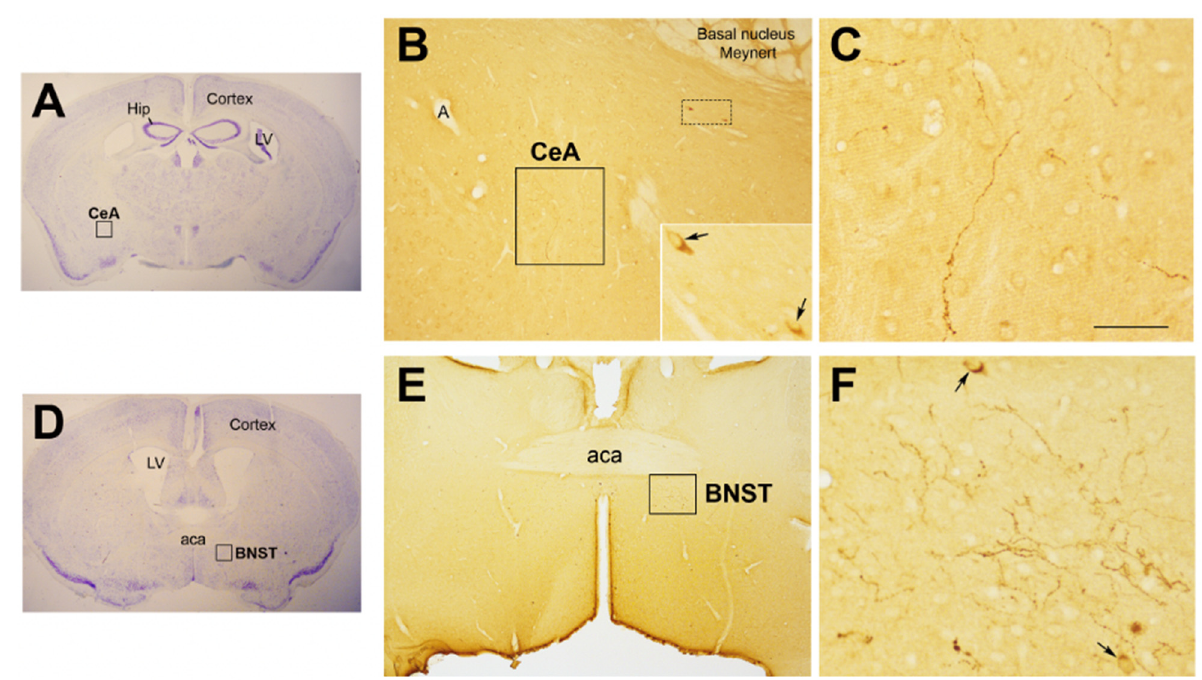
Figure 2. Oxytocinergic projections in the central nuclei of the amygdala (CeA) and in the bed nucleus of the stria terminalis (BNST). ( A ) Light microscopy (LM): Nissl-stained brain coronal section of bregma − 0.94 mm; Hip: hippocampus; LV: lateral ventricle; CeA: central nuclei of the amygdala. ( B ) LM: peroxidase immunohistochemistry of oxytocin (Oxt), showing oxytocinergic fibers (framed area) and two parvocellular Oxt neurons (dotted framed area) in the CeA. Inset: enlargement of the dotted framed area, where Oxt-positive neurons are indicated by arrows. ( C ) Enlargement of the area framed in ( B ), rich in Oxt-positive fibers. ( D ) LM: Nissl-stained brain coronal section of the bregma 0.02 mm; BNST: bed nucleus of the stria terminalis; aca, anterior commissure. ( E ) LM: peroxidase immunohistochemistry of oxytocinergic projections in the BNST. ( F ) Enlargement of the area framed in ( E ) showing Oxt neurons (arrows) and Oxt projections in the BNST. All figures relate to a 6-month-old male C57BL/6 mouse. Bregma reference sections from “The Mouse Brain Atlas”, Paxinos and Franklin (2001). The scale bar is only specified in C and corresponds to different µ m in each figure, as follows: in ( A , D ): 2300 µ m; ( B ): 200 µ m, inset 50 µ m; in ( C ): 50 µ m; in ( E ): 300 µ m; in ( F ): 50 µ m. All figures are original. Methodological details are available in the Supplementary Materials S1.